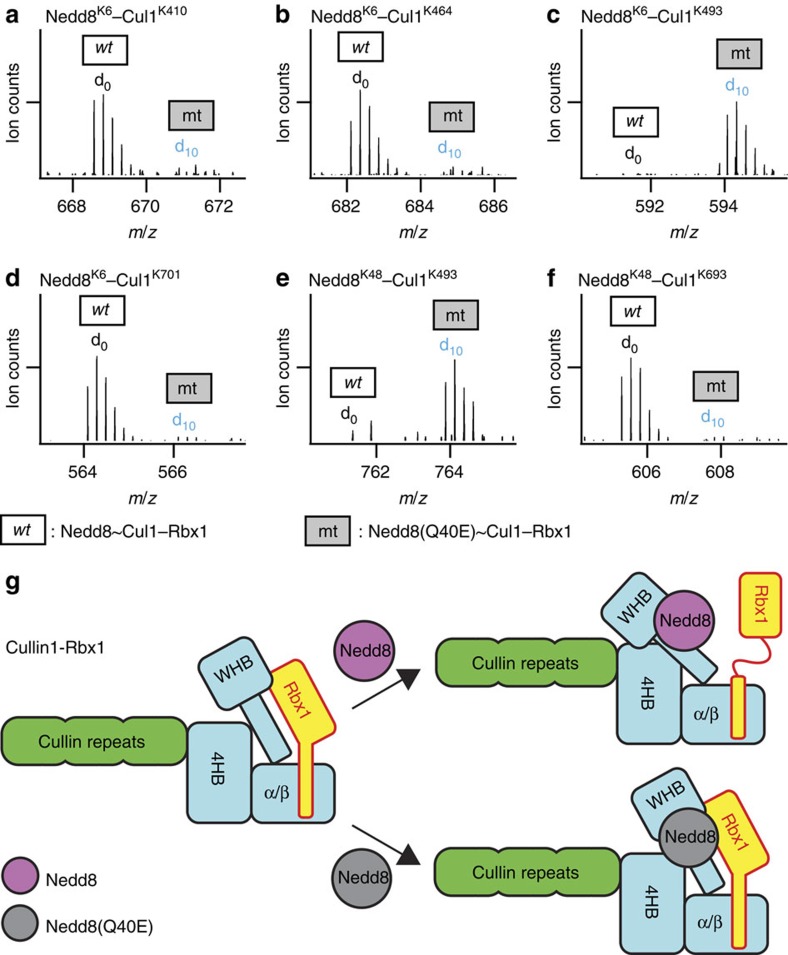
Elucidation of structural dissimilarities between wt- and mt-neddylated Cul1–Rbx1 complexes by quantitative analysis of Cul1–Nedd8 interlinks.MS1 spectra of (a) Nedd8K6–Cul1K410, (b) Nedd8K6–Cul1K464, (c) Nedd8K6–Cul1K493, (d) Nedd8K6–Cul1K701, (e) Nedd8K48–Cul1K493 and (f) Nedd8K48–Cul1K693. The mt form was d0-DMDSSO cross-linked, and the wt form was d10-DMDSSO cross-linked. (g) Proposed models for Nedd8-dependent conformational changes of the Cul1–Rbx1 complex.